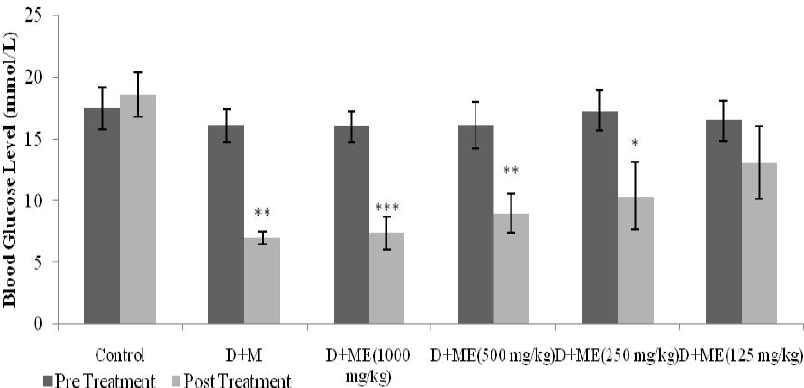
Figure 4. The effects of oral administration twice daily of 125 mg/kg, 250 mg/kg, 500 mg/kg, 1000 mg/kg of the methanolic extract (ME) of S. polyanthum leaf and metformin (M) 500 mg/kg on blood glucose levels in streptozotocin-induced diabetic rats. Values were